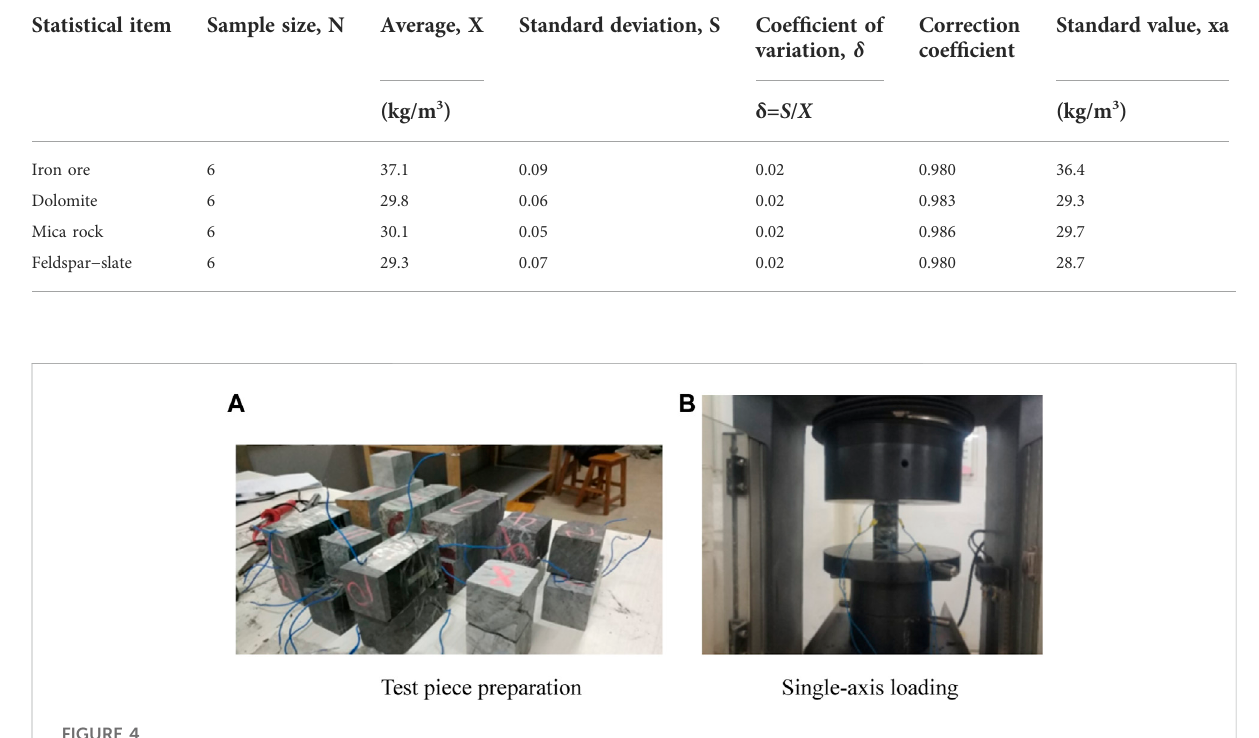
Figure 4A. During the experiment, the loading speed was set to 0.5 MPa/s, and the maximum load from the beginning of the experiment to the time of damage to the specimen was recorded, as shown in Figure 4B. The experimental results are shown in Table 2. According to the uniaxial compressive strength test, the uniaxial compressive strength, elastic modulus, and Poisson ’ s ratio of iron ore were 185.57 MPa, 7.4×104 MPa, and 0.24, respectively; the uniaxial compressive 120.96 MPa, 7.34×104 MPa, and 0.22, respectively. The uniaxial